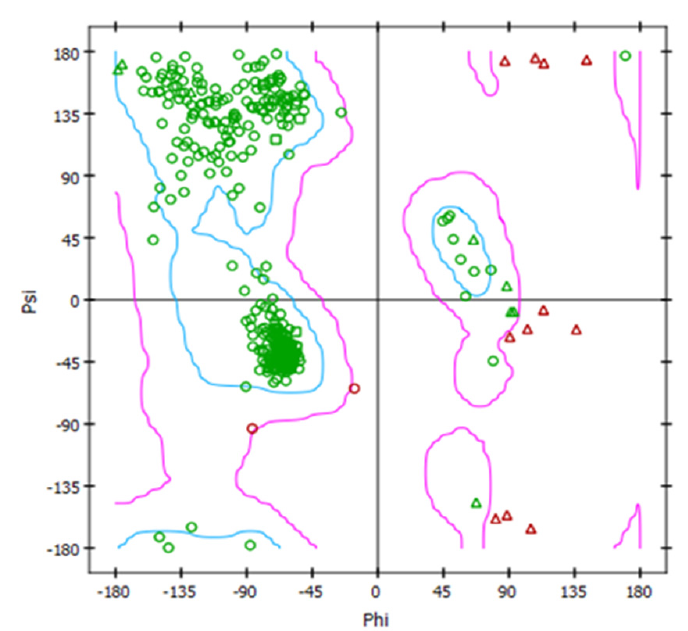
Figure 8. Ramachandran plot of the modeled C. auris 14- α -demethylase enzyme.